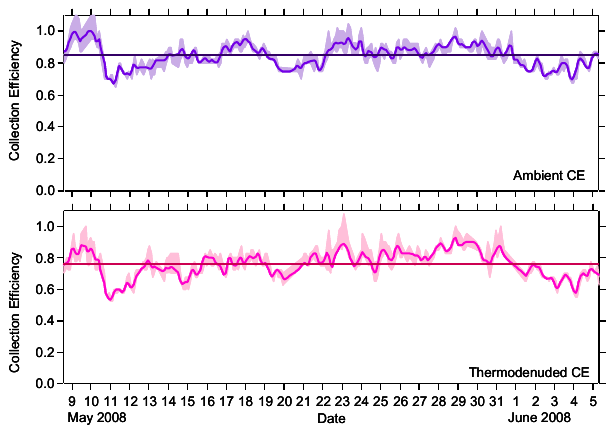
Figure 2. Changes in the AMS collection efficiency for the ambient (top) and thermodenuded (bottom) aerosol during month long FAME-2008 period. The shading represents the solutions within 10% of the minimum error score of the distribution matching algorithm and the horizontal lines represent the mean value.